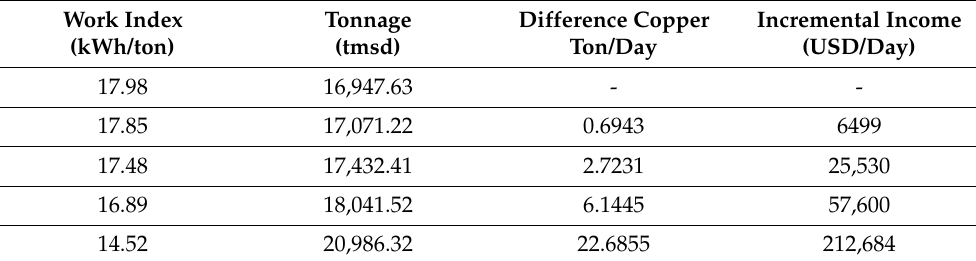
Figure 12. Simulation parameters: mill dimensions and operating conditions. The incremental income is due to the increase in processed tonnage. The parameters used to calculate income are: recovery of 82% [30], ore grade of 0.685% [30], and copper price of 425.402 cUSD/lb [31]. Table 2 summarizes the results for the different work indices. Notice that the increment in tonnage is highly nonlinear. Table 2. Incremental income due to a reduction in work index.